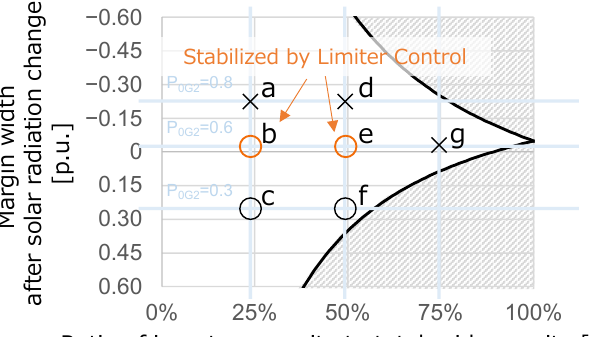
Figure 14. Stability result of the ramp changing irradiance PV-VSM with limiter control. In this figure, a–g corresponds to the labels of the simulation case. ◦ and × mean stable and unstable results.